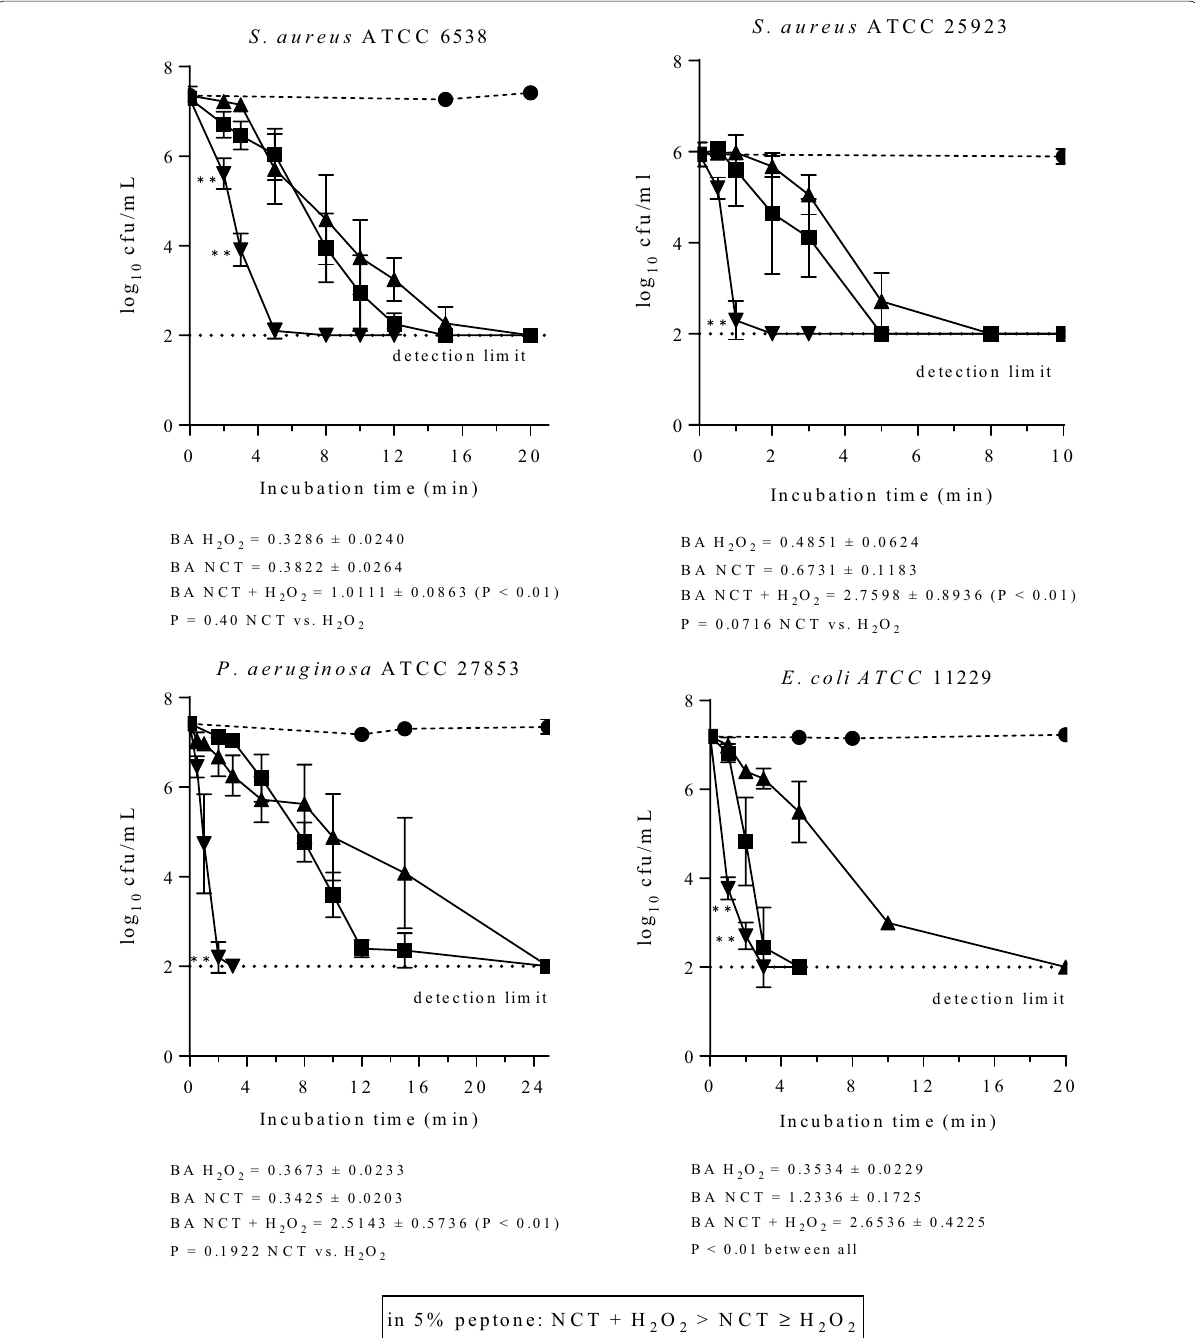
Fig. 6 Bactericidal activity of 1% NCT ( filled square ), 1% H 2 O 2 ( filled triangle ), and 1% NCT plus 1% H 2 O 2 ( inverted triangle ) at pH 7.1 and 37 °C in the presence of 5% peptone. Control in phosphate buffer plus 5% peptone ( filled circle ). Mean values ** P < 0.01 versus all other values. BA values calculated as in Fig.